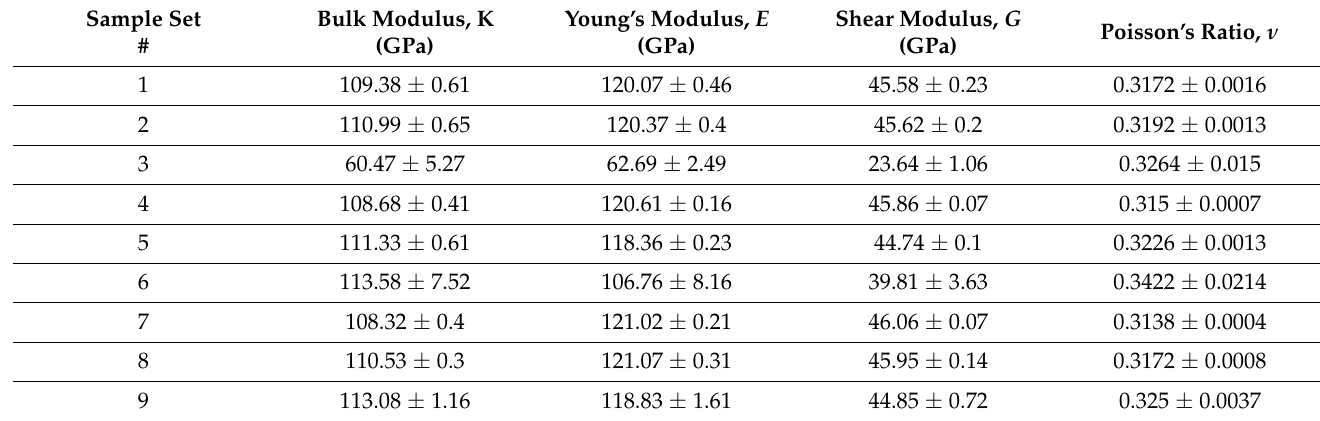
Table 3. Elastic moduli values of the various samples.